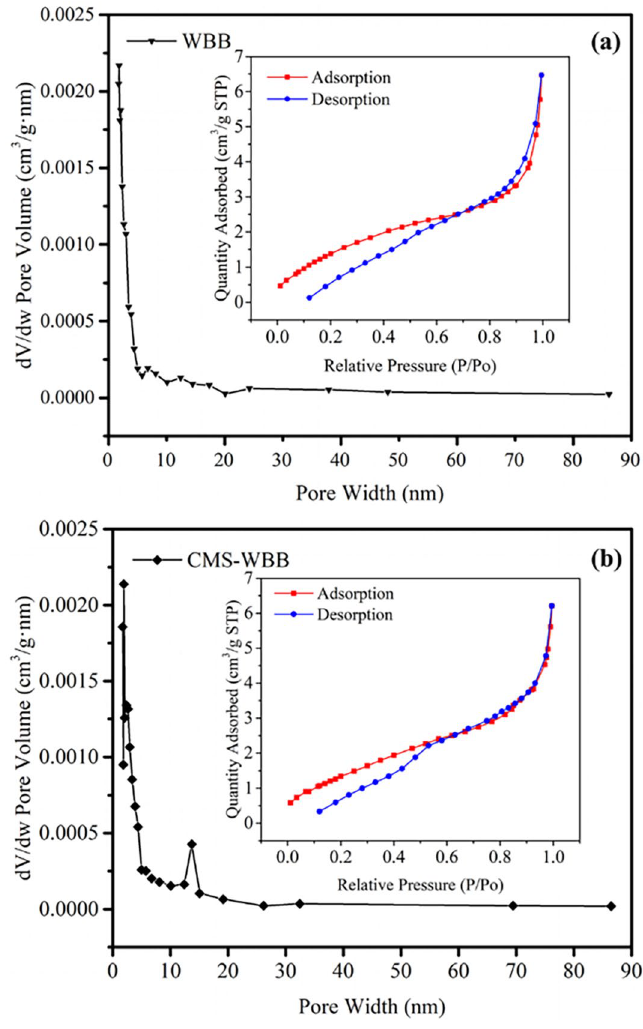
Figure 4. N 2 adsorption and desorption isotherms and pore diameter distribution of WBB ( a ) and CMS-WBB ( b ).